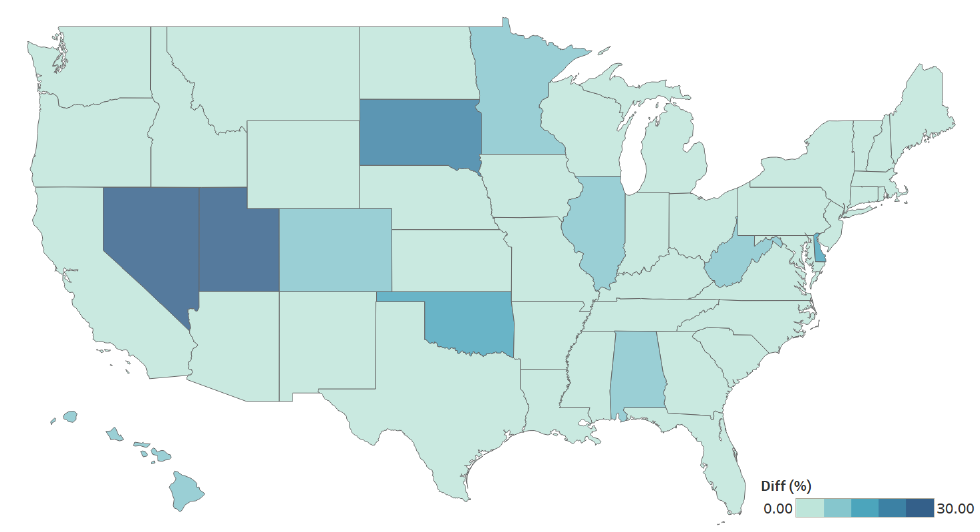
Figure 5. Absolute relative differences (%) between state-level survey and model point estimates for estimates of the number of all hired agricultural